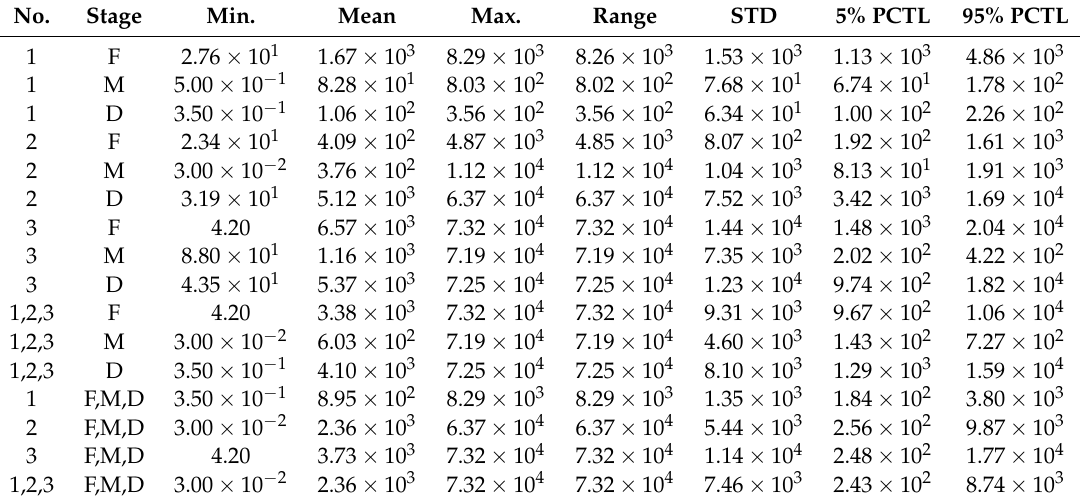
Table 4. Statistical measures of Ω derived from the MGD parameters of the three fog events (Nos. 1, 2 and 3) in Formation (F), Mature Stage (M) and Dissipation (D): Minimum (Min.), Mean,